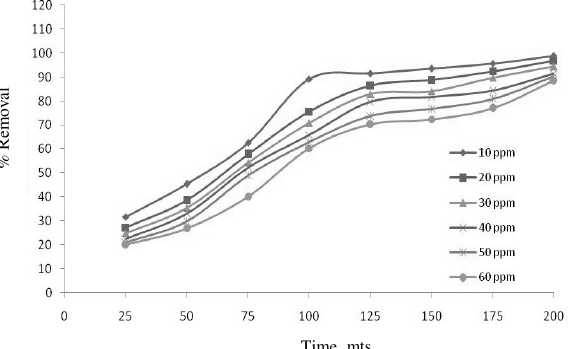
Figure 3. The effect of adsorbent doses on RHD dye onto ZAWAC